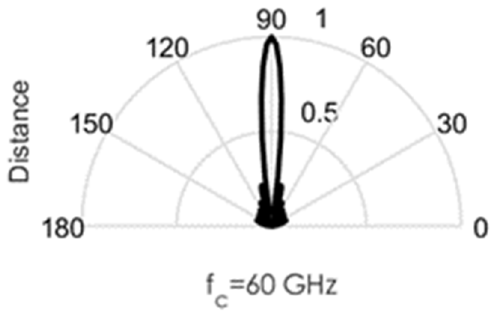
Figure 5. Directional beams produced by uniform linear arrays (ULA) operating at 60 GHz; 12 array elements with λ /2-spacing; steering vector A = [1 1 1 1 1 1 1 1 1 1 1 1].